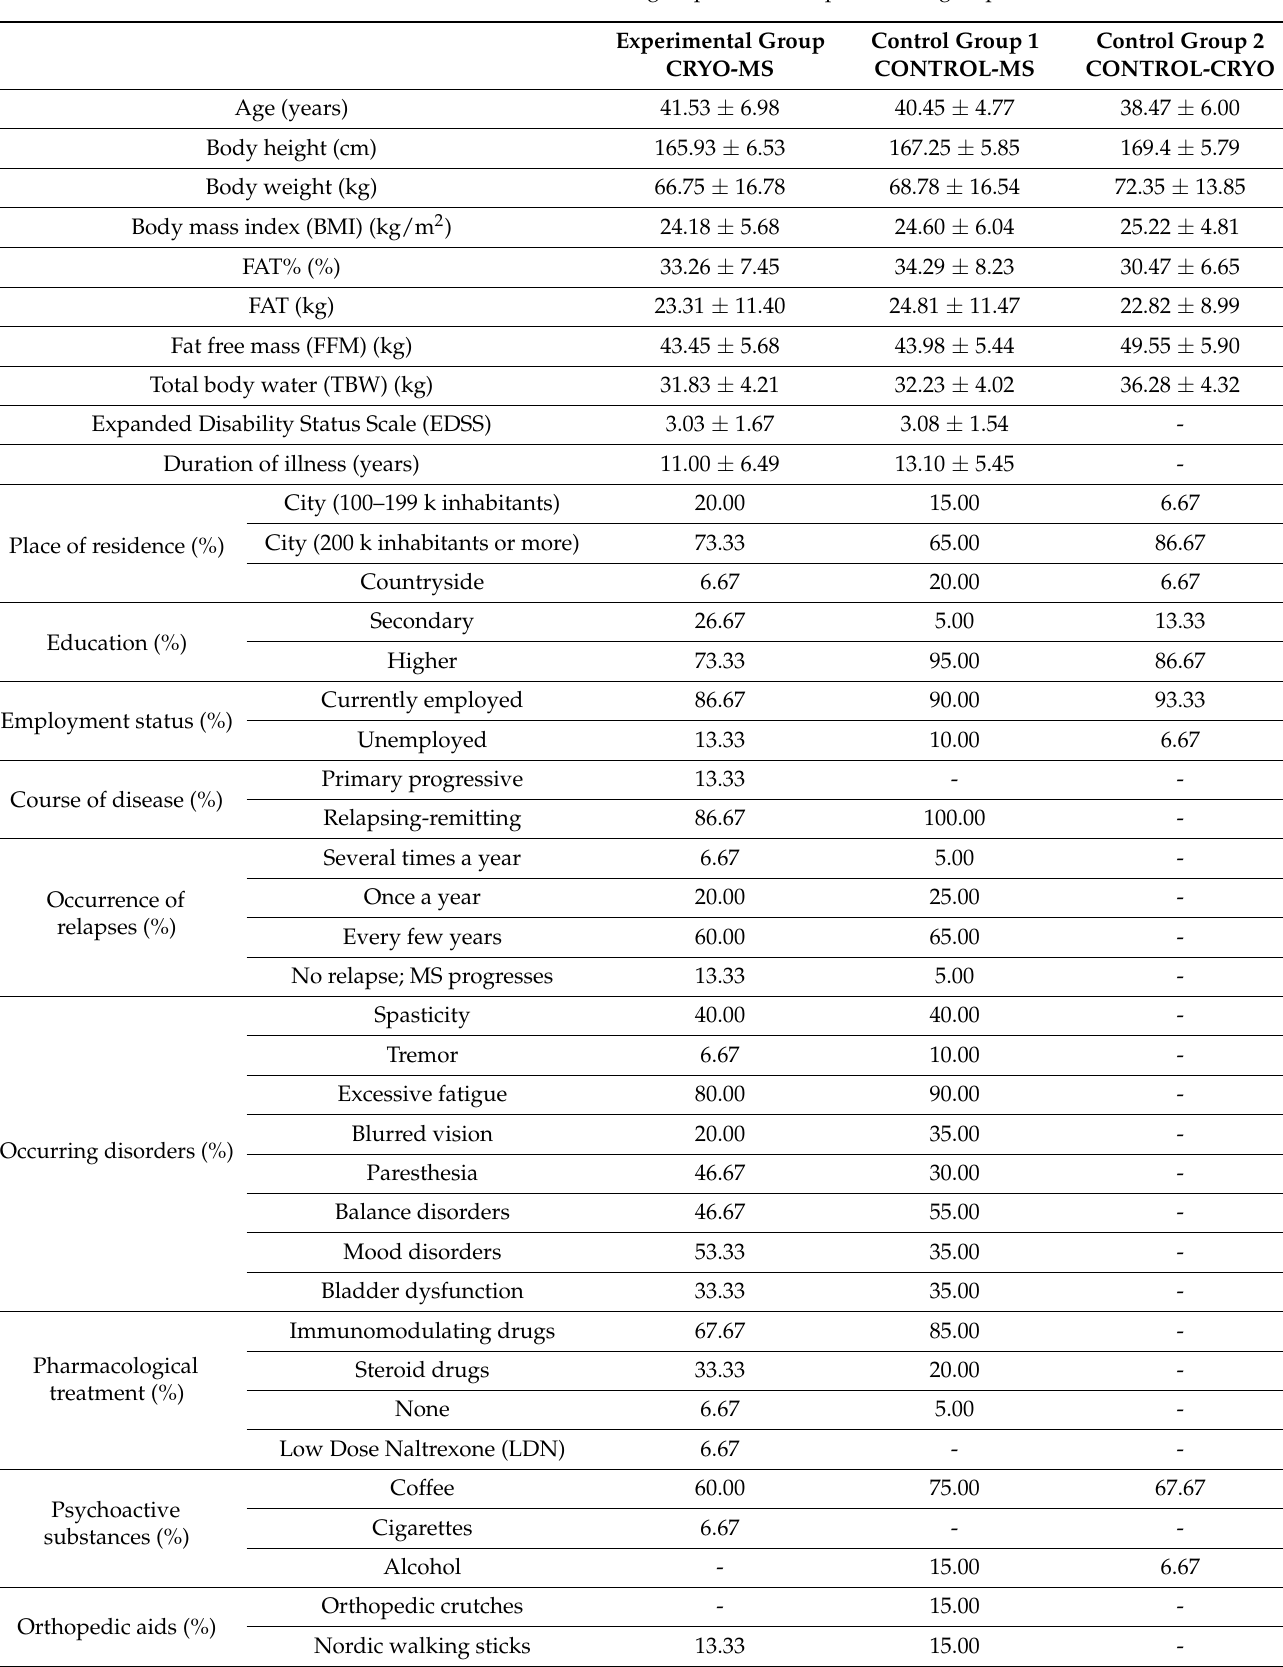
Table 1. Characteristics of the control groups and the experimental